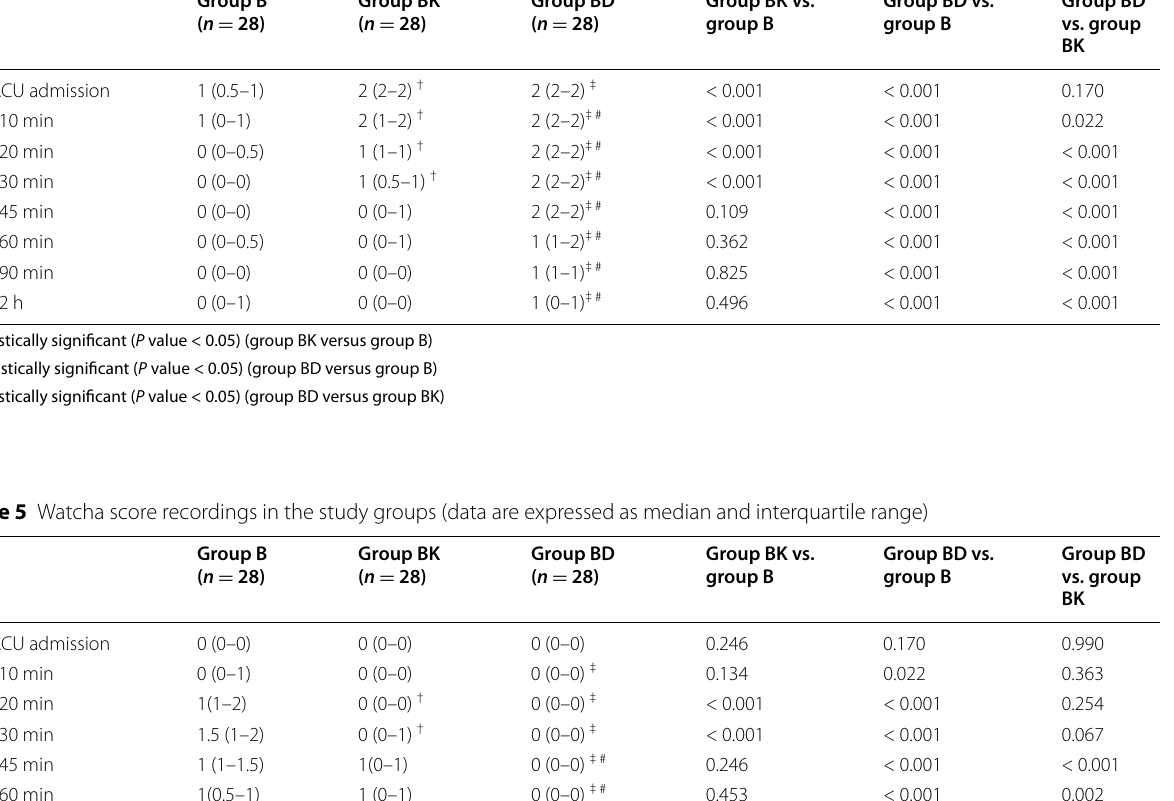
Table 4 Four-point sedation scores recordings in the study groups (data are presented as median and interquartile range)